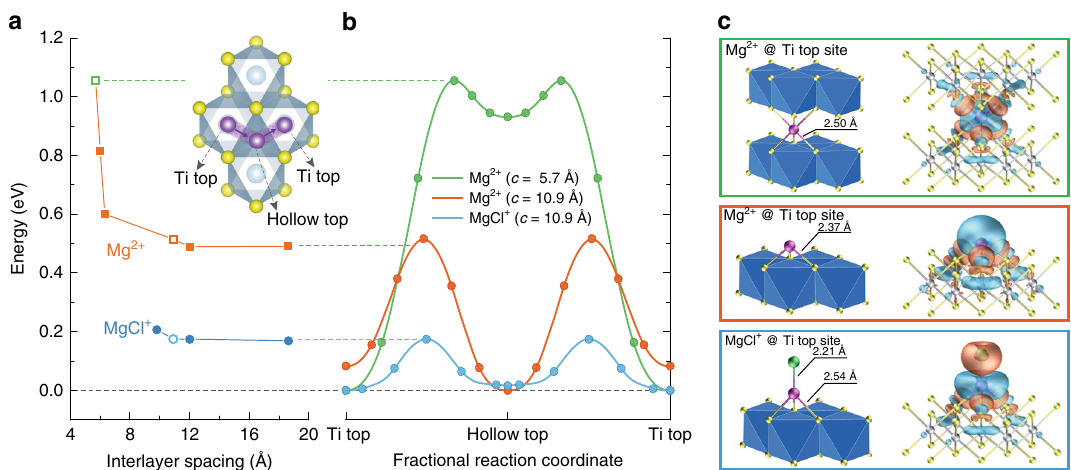
Fig. 2 First-principles calculations for the diffusion of Mg-ions in TiS 2 . a Energy barrier for the migration of Mg 2+ and MgCl + as a function of the interlayer distance of TiS 2 at the dilute limit. The diffusion path from a Ti top to another Ti top site via the adjacent Hollow top site is shown in the inset. b Energy diagrams along the diffusion path for the three representative cases of Mg 2+ at c = 5.7 Å ( green ), Mg 2+ at c = 10.9 Å ( orange ), and MgCl + at c = 10.9 Å ( cyan ). c Atomic con fi gurations of Mg 2+ and MgCl + at Ti top site for the three cases in b . The right panels show the charge difference plots constructed by subtracting the valence electron density of individual Mg atom, Cl atom, and TiS 2 layers from that of Mg@TiS 2 or MgCl@TiS 2 . Blue and orange colors represent depletion and accumulation of electron,